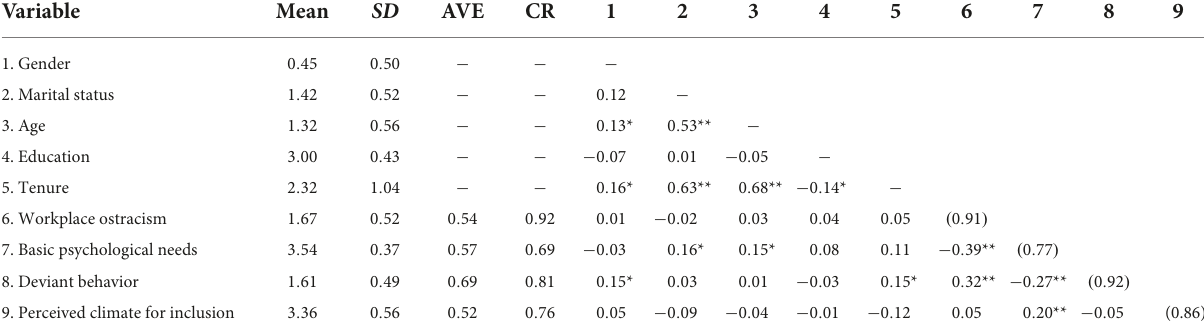
TABLE 3 Means, standard deviations, and correlations of the focal variables.